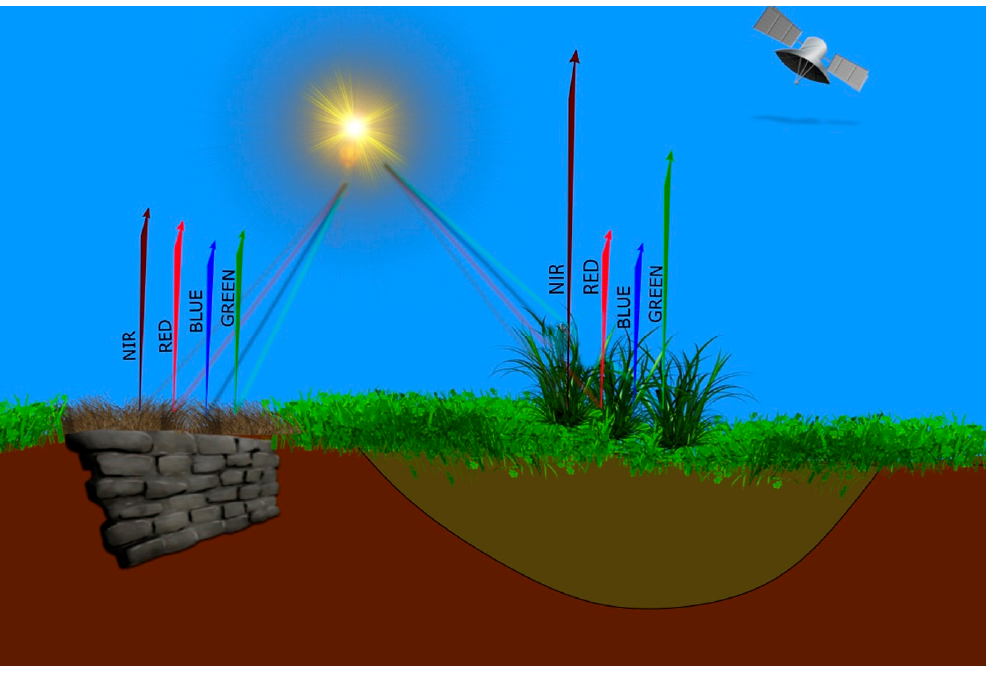
Figure 3. The physical principle of how vegetation indices are calculated. The near-infrared (NIR) and red wavelengths are strongly reflected in areas with higher or denser vegetation.